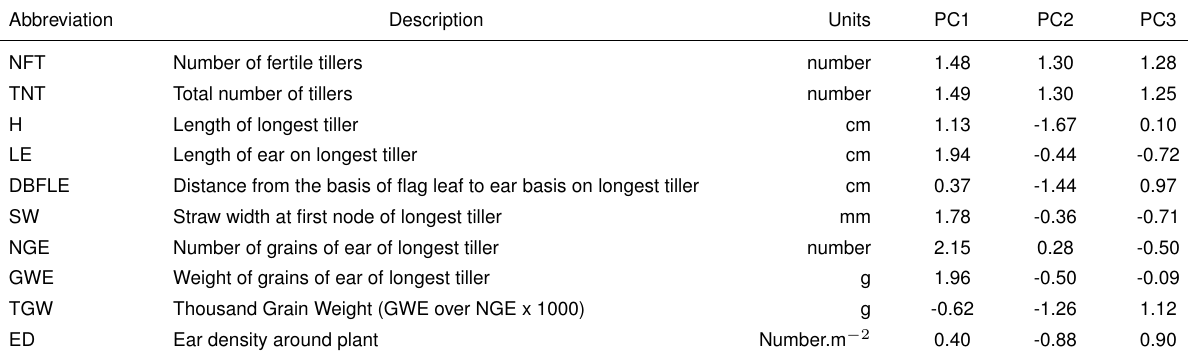
Table 3. Description of contributions of each variable to the three principal components PC1, PC2 and PC3.